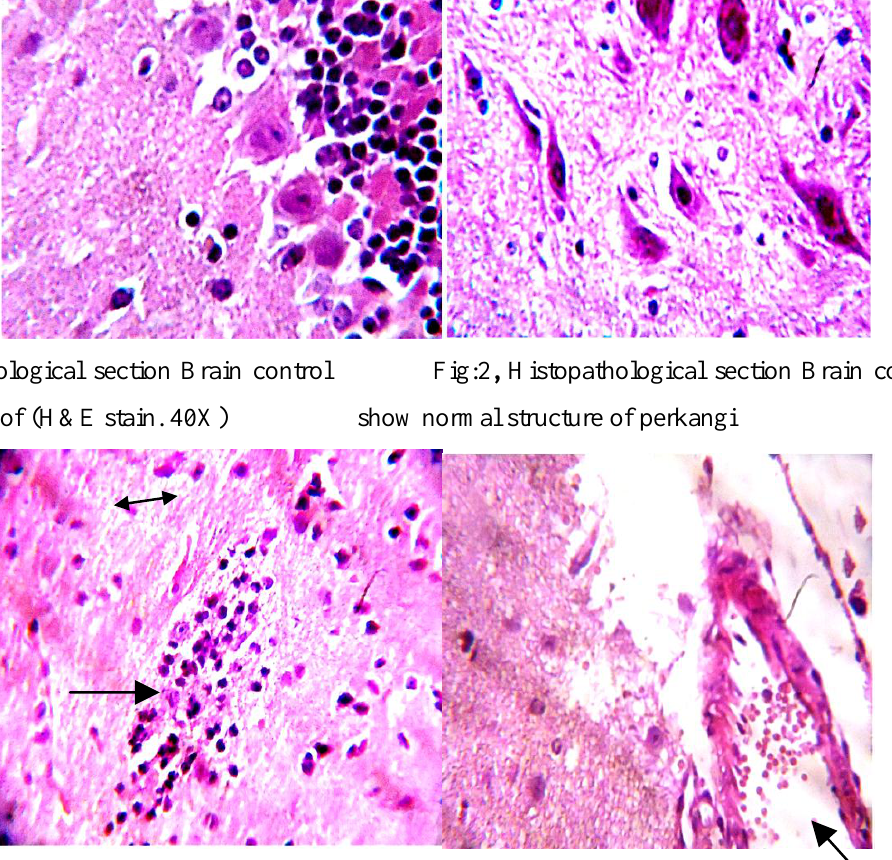
Fig.3, Histopathological section in Brain of T1 Fig.4, Histopathological section in Brain of T1,show shows proliferation of astrocyt in white matter congestion of B.V with neutrophils in the lumen of cerebellum and aggregation of neutrophils around congested B.Vs(H&E stain. 40 X) (H&E stain. 40